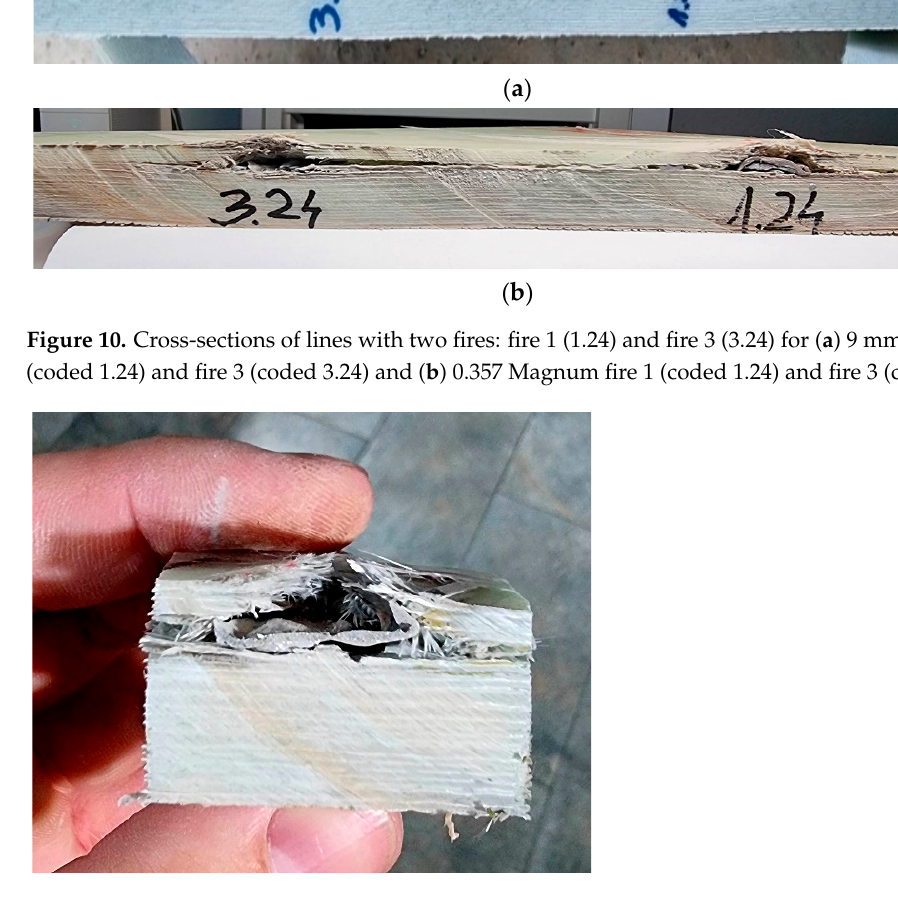
( f ) 0.357 Magnum Figure 12. SEM images of the panel cross-section: ( a – c ) for 9 mm FMJ, ( d – f ) for .357 Magnum. (a) Top view of the penetration hole produced by the 9 mm FMJ; (b) Detail of the surface that the projectile was stopped on (fragments of the projectile are not in this image, but there are glass fiber fragments); (c) Shear cut of a glass fiber (up), typically for impacted glass fibers, meaning a cut sur- face almost perpendicular to the fiber axis;